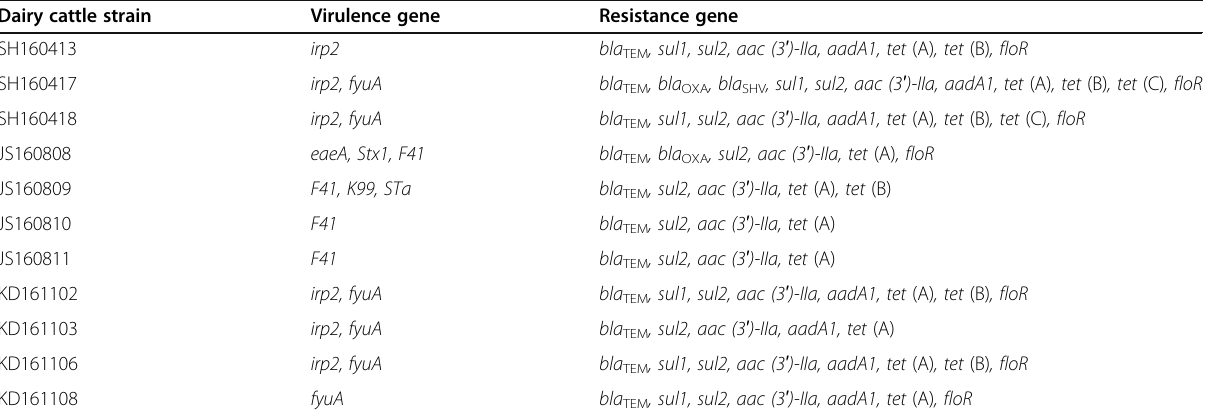
Table 6 Dairy cattle E. coli resistance genes and virulence genes Dairy cattle strain Virulence gene Resistance